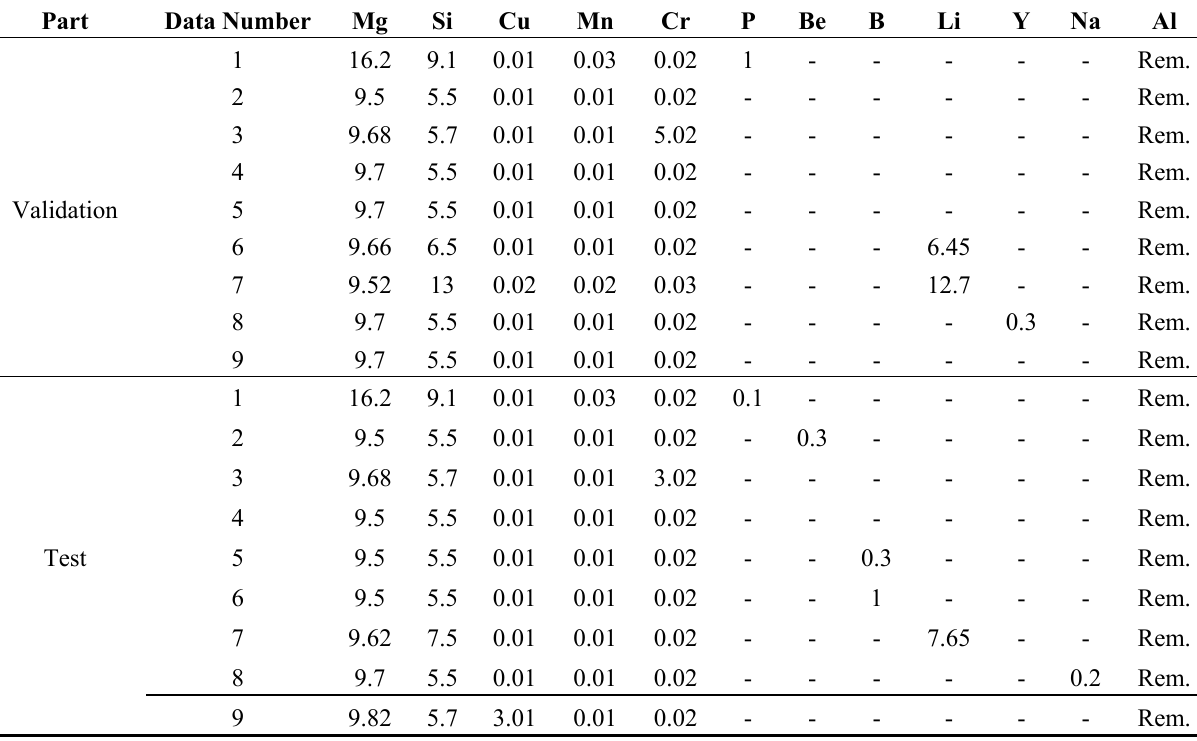
Table 2. Validation and test input data